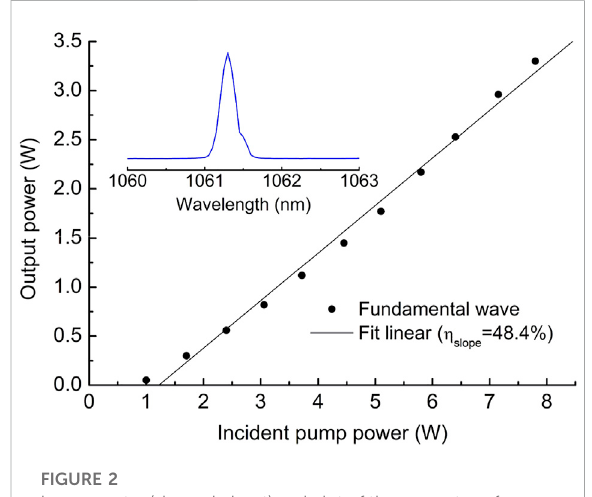
FIGURE 2 Laser spectra (shown in inset) and plot of the power transfer characteristics of the fundamental laser output.